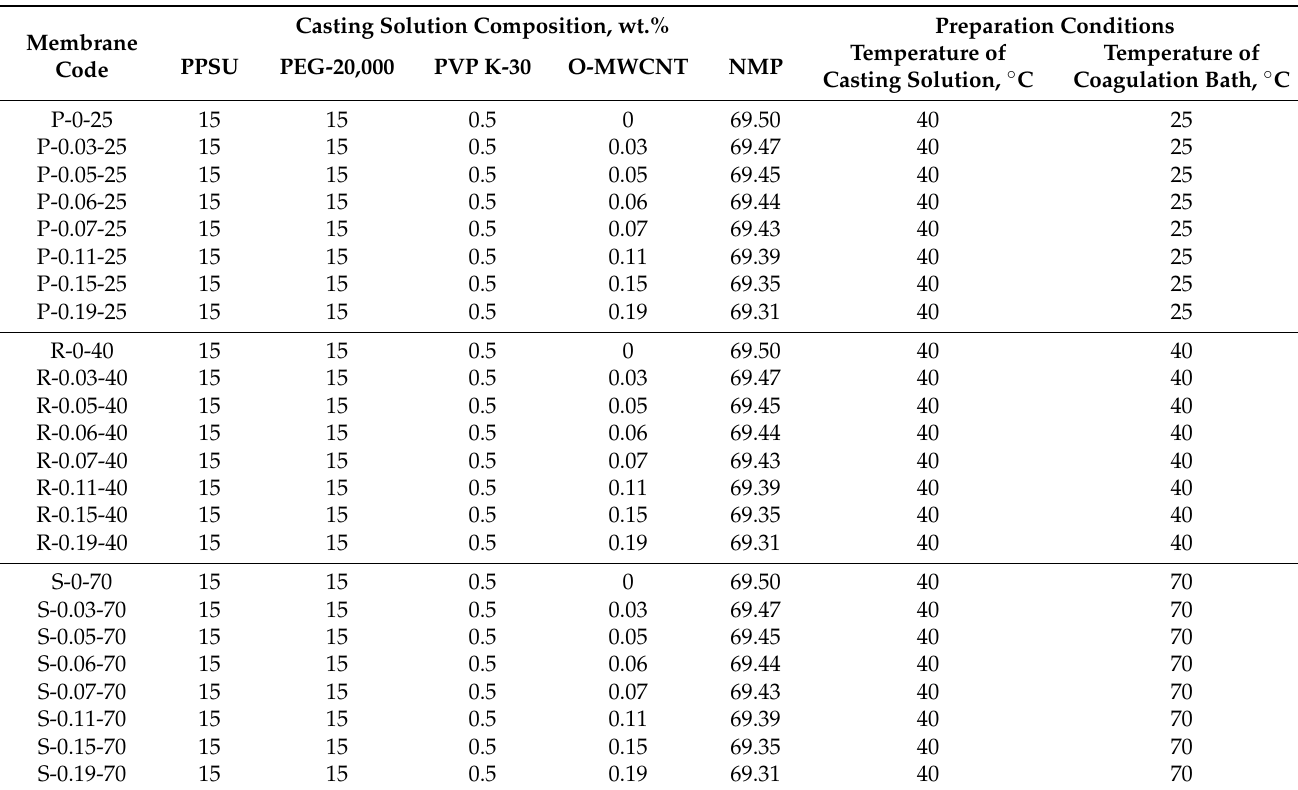
Table 2. Abbreviations of membranes, casting solution compositions and conditions of membrane